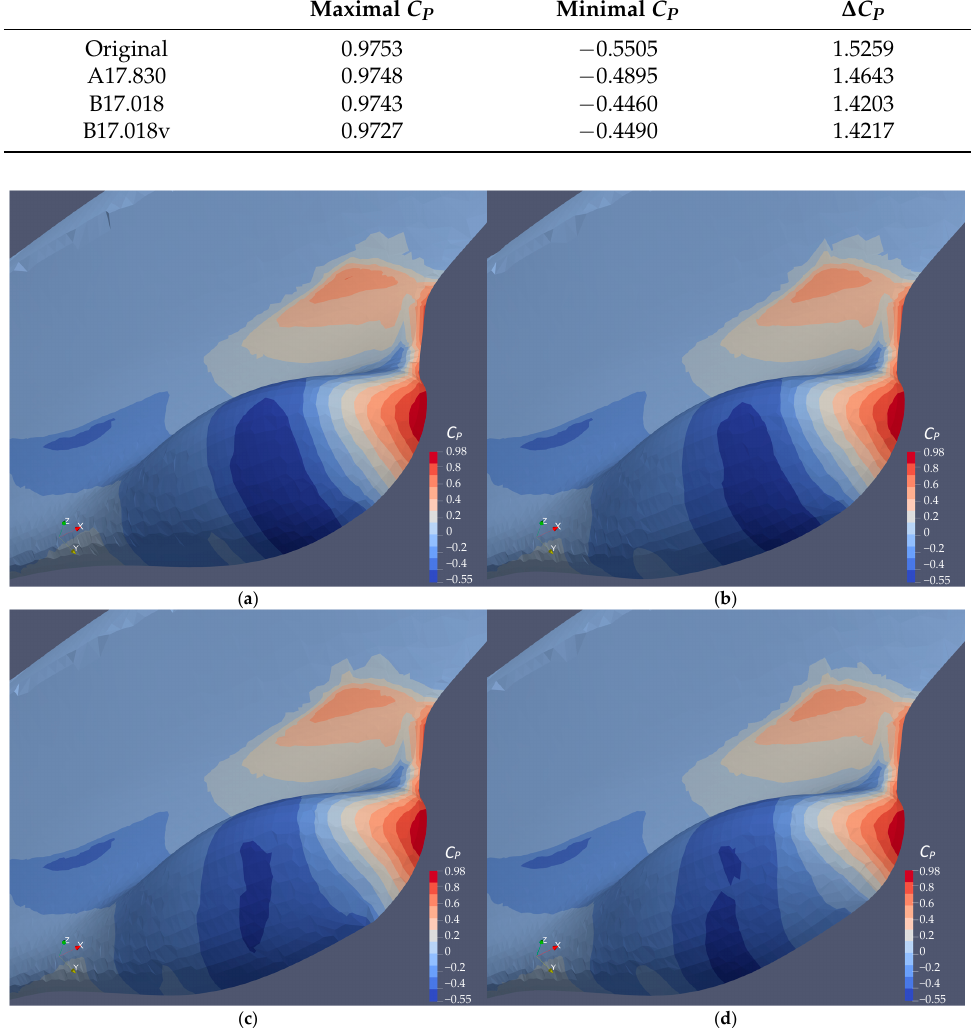
Table 8. Maximal and minimal C P , and the difference between them ( ∆ C P ) on bow surfaces.